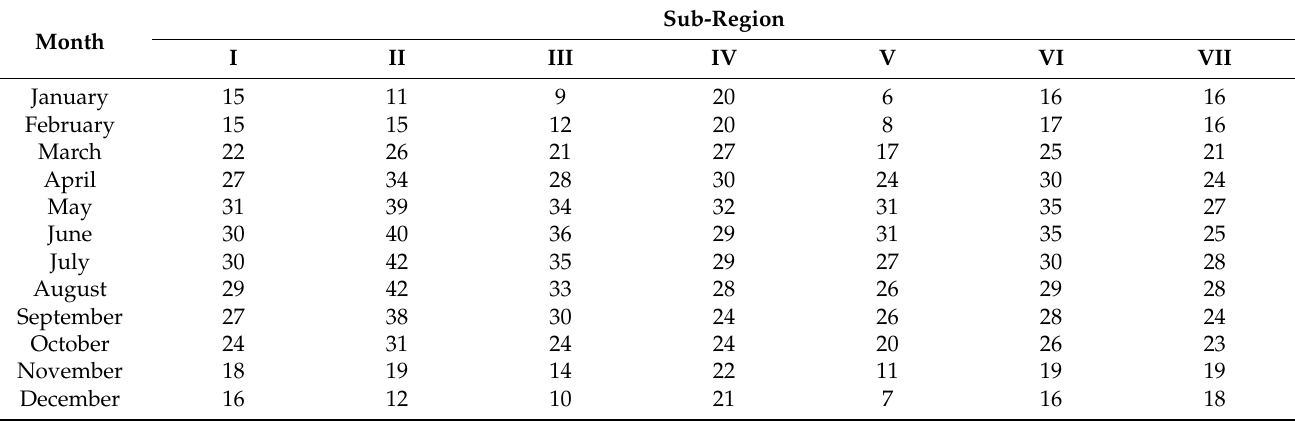
Table 1. Values of the monthly D in different sub-regions and months. Unit: mm month − 1